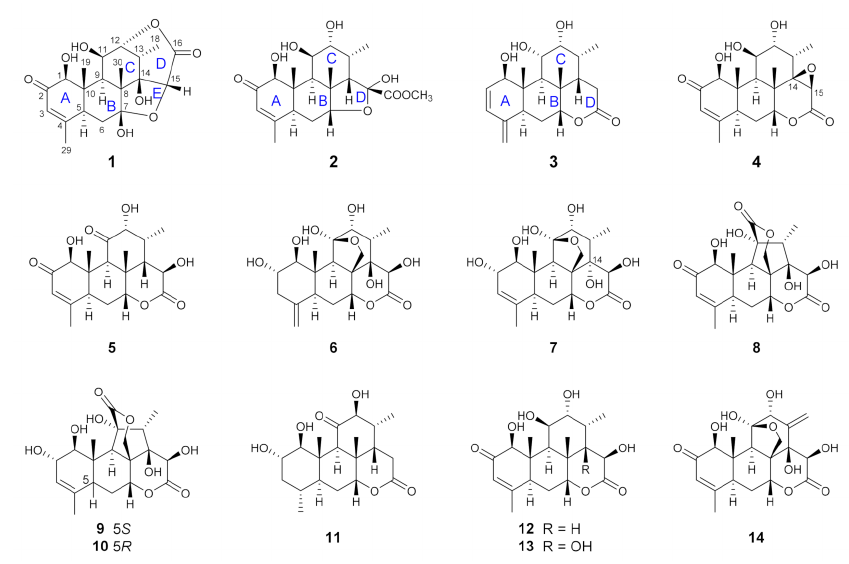
Figure 1. Chemical structures of quassinoids isolated from the roots of E. longifolia